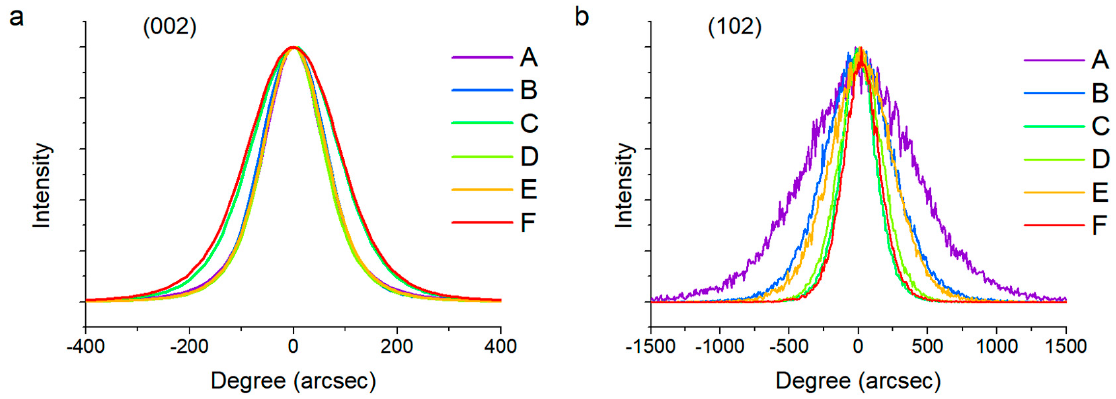
Figure 3. The (002) ( a ) and (102) ( b ) ω scan of samples A, B, C, D, E, and F. Samples A, B, and C have the same precursor flow rate. In all these samples, A has the largest AlGaN β (100) whereas C has the smallest. Among the four samples having additional AlGaN growth, samples C and F have relatively smaller AlGaN β (100), but sample E has far larger β (100) than the other three